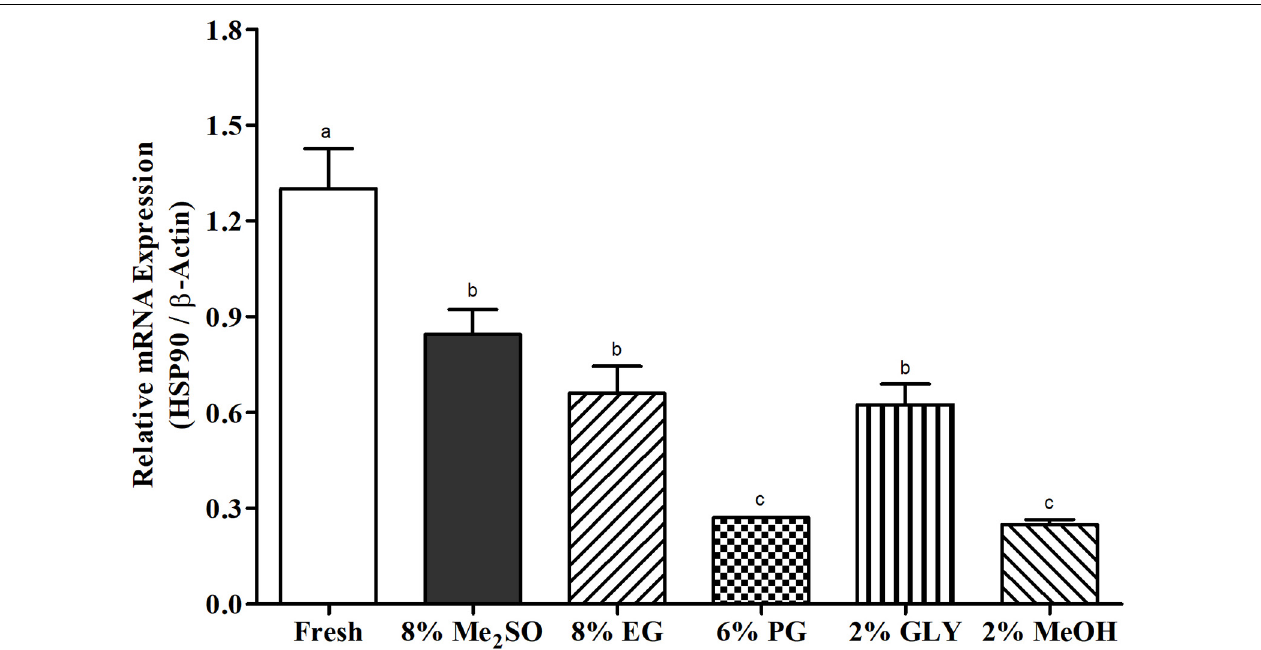
FIGURE 3 | HSP90 mRNA expression levels in fresh and cryopreserved sperm samples ( n = 3) of Pacific abalone, H. discus hannai . Expression values of HSP90 mRNA were normalized against average (cid:49) CT values of control. Different superscript letters (a–c) above bars indicate significant ( p < 0.05) differences between fresh and cryopreserved sperm samples.